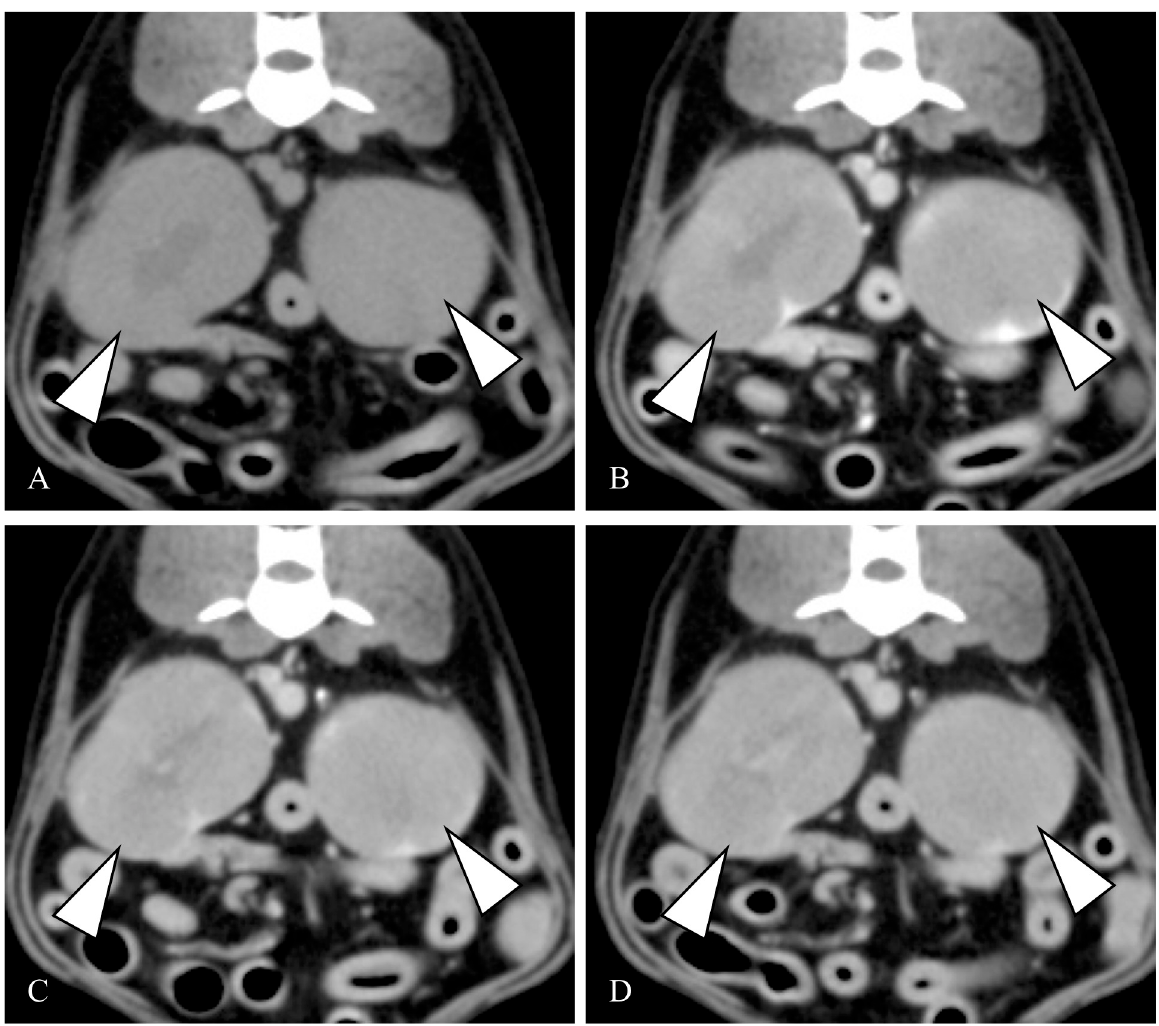
Fig 4. Representative axial pre-contrast (A) CT image of a lymphoma and post-contrast corticomedullary (B), nephrographic (C), and excretory (D) phase CT images of the lymphoma. The tumor had bilateral involvement and showed homogeneous enhancement (arrowhead). Abbreviations: CT, computed tomography.